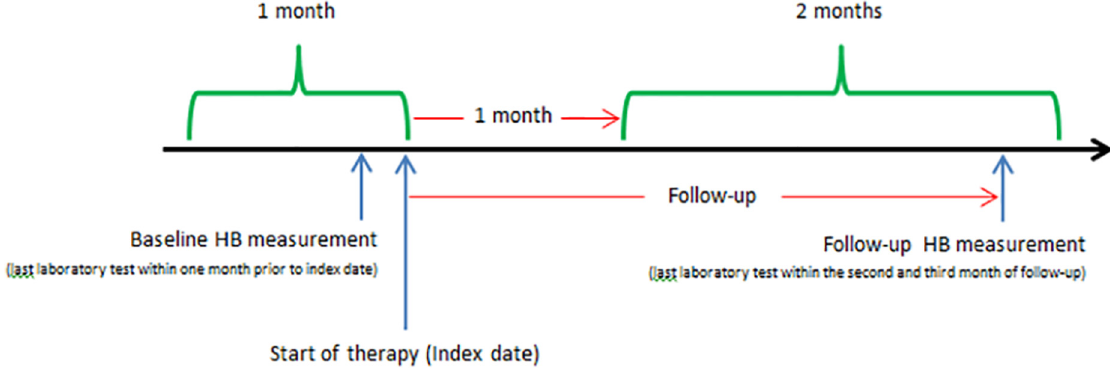
Fig 1. Depiction of follow-up period and Hb measurements. Hb =